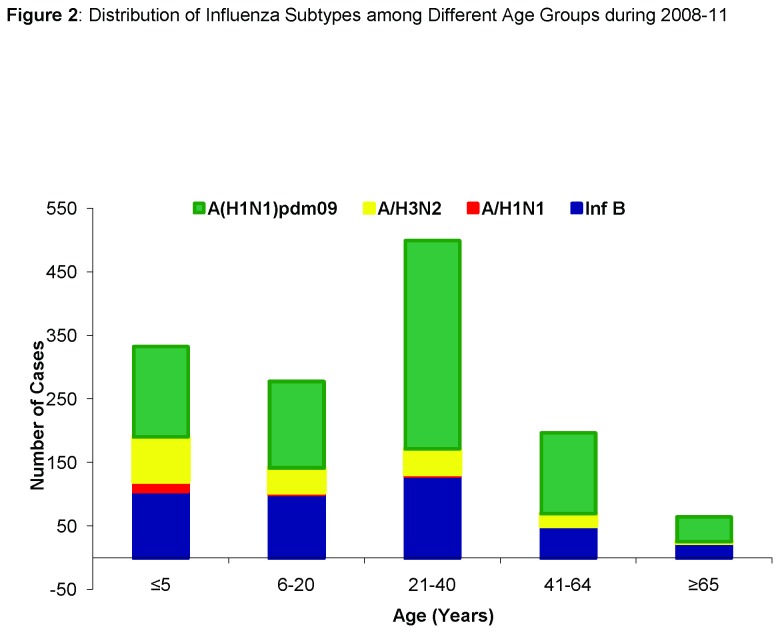
Distribution of Influenza Subtypes among Different Age Groups during 2008-11.Pattern of influenza viruses detection by subtypes in different age groups. Influenza B is shown in Dark blue, A/H1N1 in Red, A /H3N2 in Yellow and A/H1N1 pdm 09 in Green. Note: Cases with missing age data were not included.